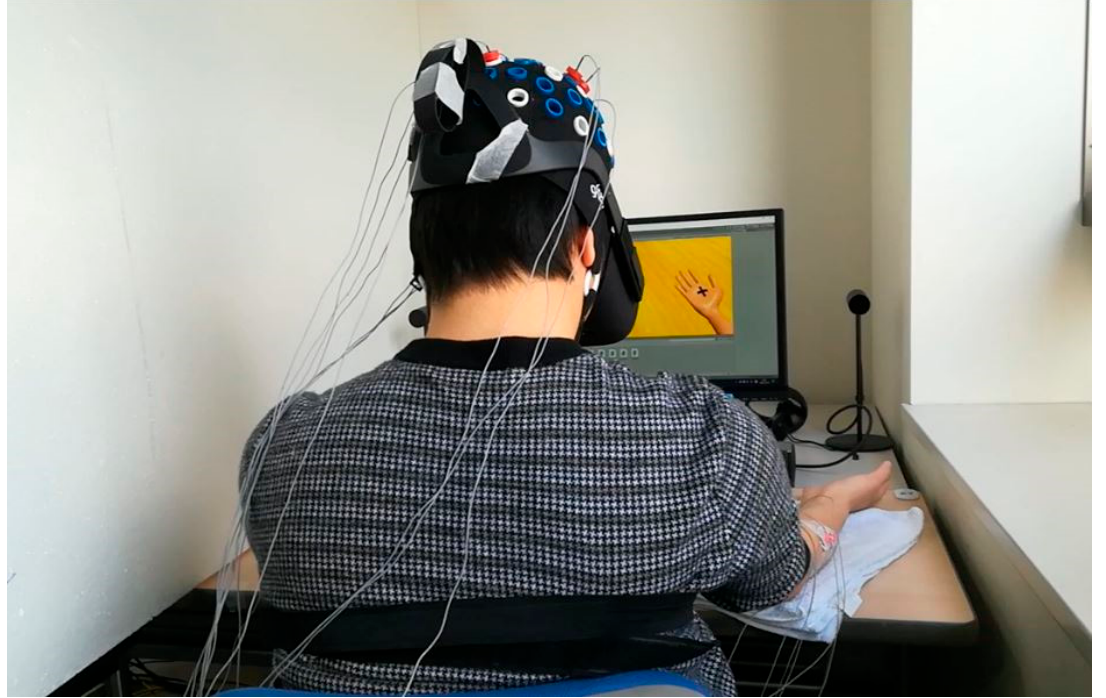
Figure 1. Experimental design for motor task performance using the 3D-HMD condition in the VR environment.